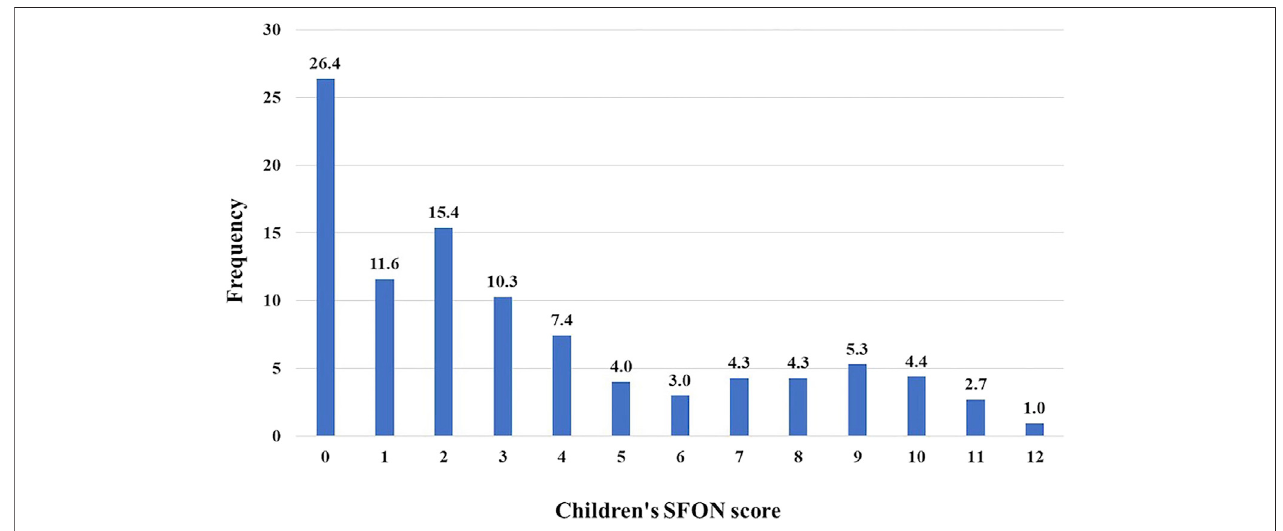
FIGURE 3 | Frequencies of children ’ s